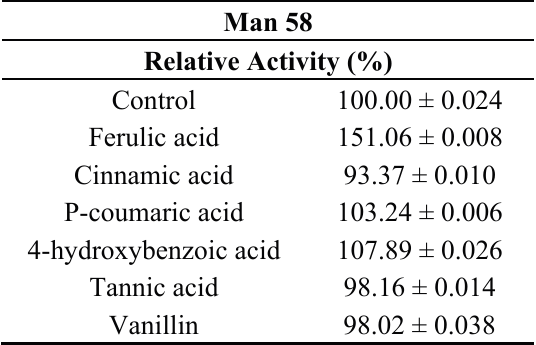
Table 2. The effect of phenolic compounds in activity of Man